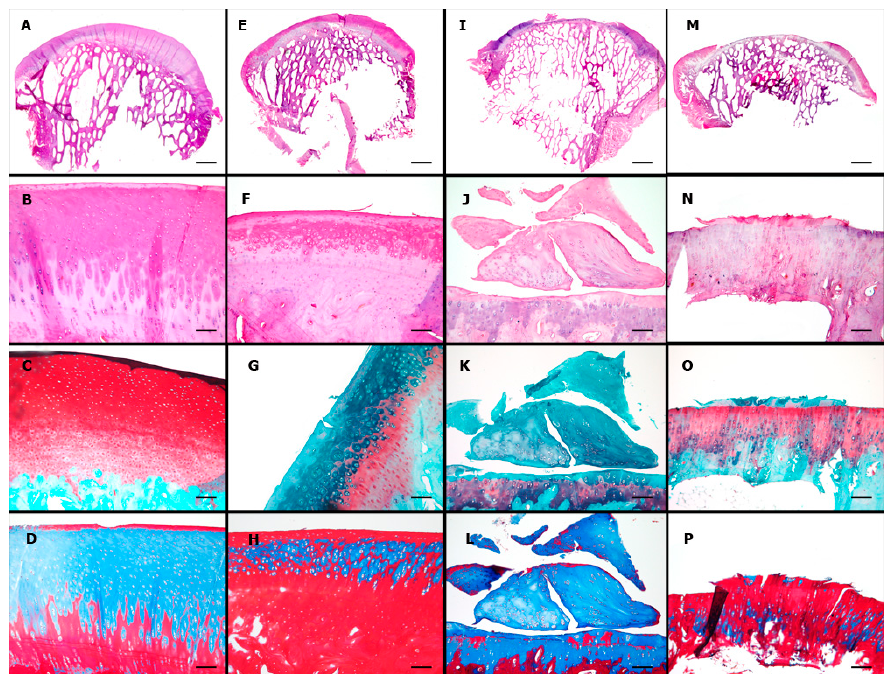
Figure 7. Microscopic results: first row, panoramic view; second row, H&E stain; third row, Safranin O (used to color in red the glycosaminoglycans); and fourth row, Masson’s trichrome (used to color in blue the collagens and new connective tissues). ( A ) Panoramic view by scanning; scale bar = 2 mm; (B – D ) objective, ×10; scale bars = 100 μ m: normal ovine cartilage; ( E ) scanning; scale bar = 2 mm; ( F – H ) objective, ×10; scale bars = 100 μ m: group CELLS; a smooth continuous surface with complete horizontal filling and complete integration to the borders, but partial vertical filling of the defect and an heterogeneous Safranin O staining of the extracellular matrix; ( I ) scanning; scale bar = 2 mm; ( J – L ) objective, ×10; scale bars = 100 μ m: group SCAFFOLD; defect partially filled with fibrocartilage; ( M ) scanning; scale bar = 2mm; and ( N – P ) objective, ×10: group EMPTY; defect unfilled. Scale bar = 100 μ m.